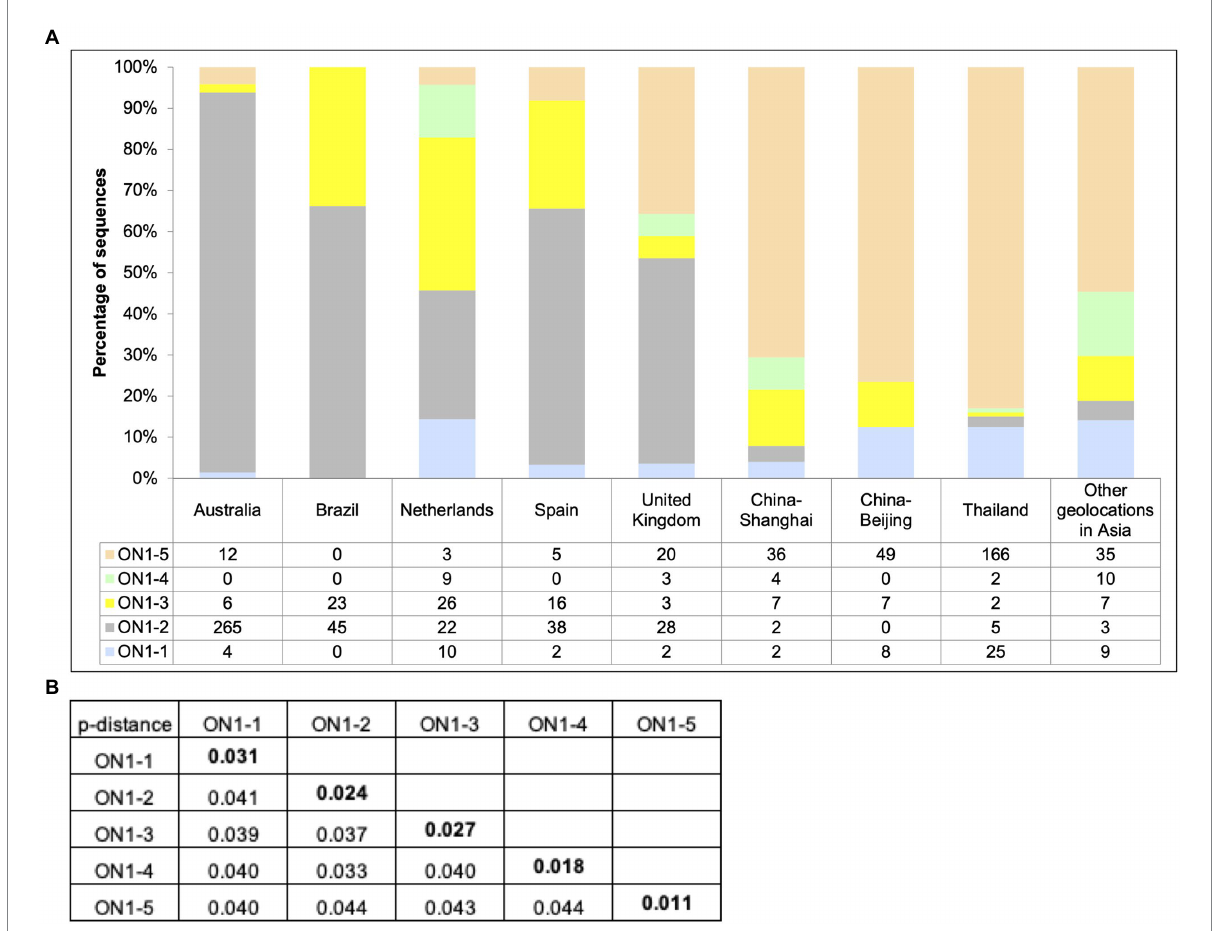
FIGURE 4 Circulation of ON1 lineages in different geolocations, January 2019–March 2021. (A) RSV-A G sequences obtained from RSV-A-positive samples in this work, and sequences from strains isolated from other geolocations between January 2019 and March 2021 available from GenBank were used to generate a phylogenetic tree using RAxML for genotype and lineage assignation. Sequences were grouped by location of isolation, and genotype and lineages were tabulated and plotted for each indicated geolocation. (B) Average pairwise distances between ON1–5 strains and other ON1 lineages were calculated using